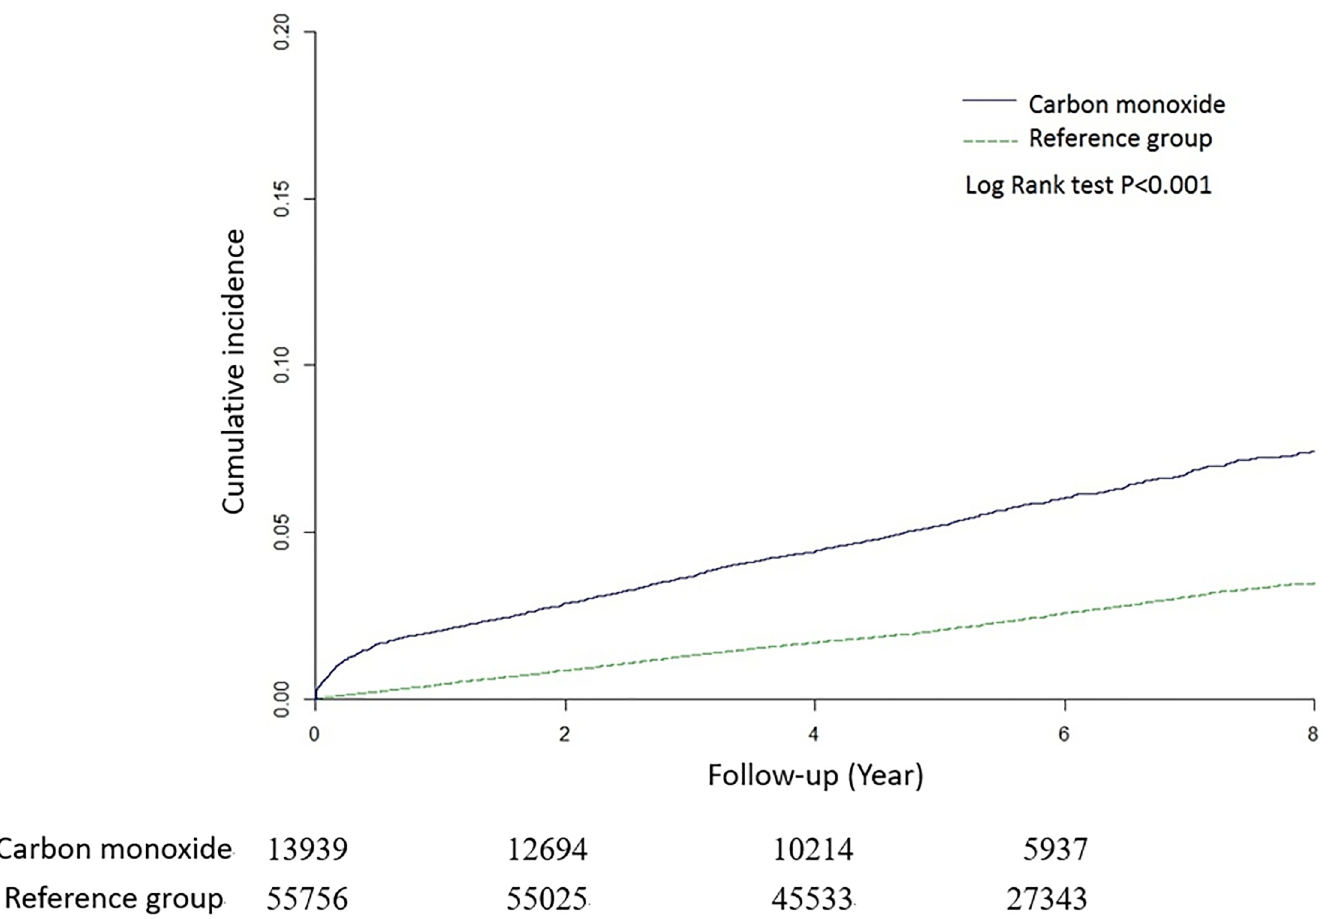
Fig 1. Plot of hazard curves for major adversecardiovascular events based on the Cox model analysis for patients with carbon monoxide poisoning and controls.